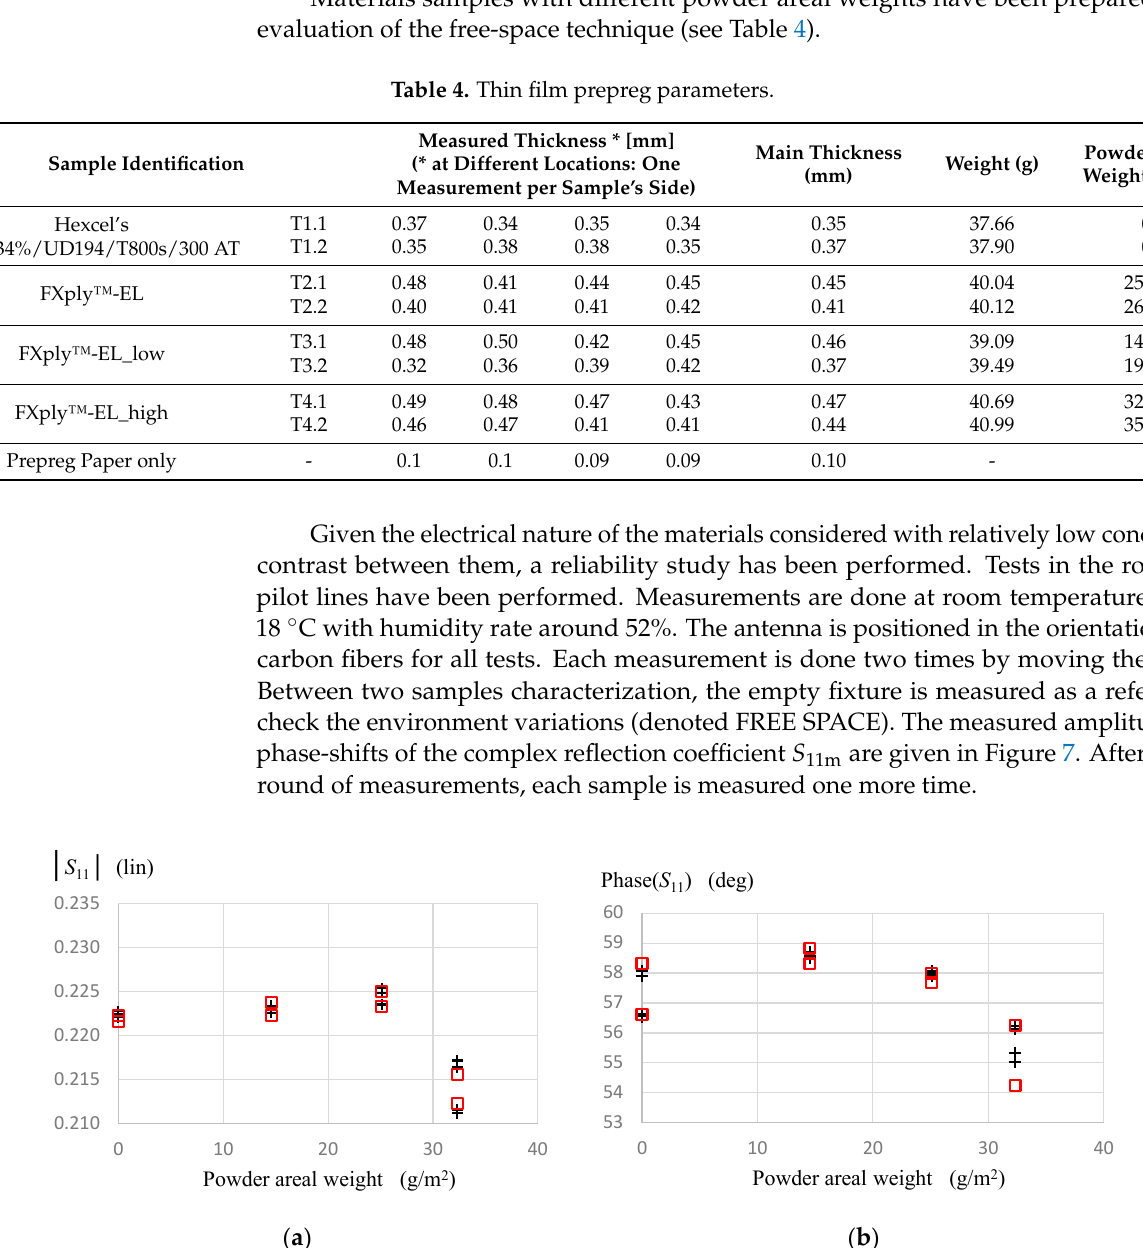
Table 4. Thin film prepreg parameters.